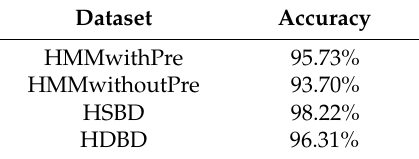
Figure 6. The confusion matrix of SDAE+LGB on each dataset: ( a ) HMMwithPre, ( b ) HMMwithoutPre, ( c ) HSBD, ( d ) HDBD. The Number in each cell is the probability of the current predicted result, while blank represents the probability is below 0.01.